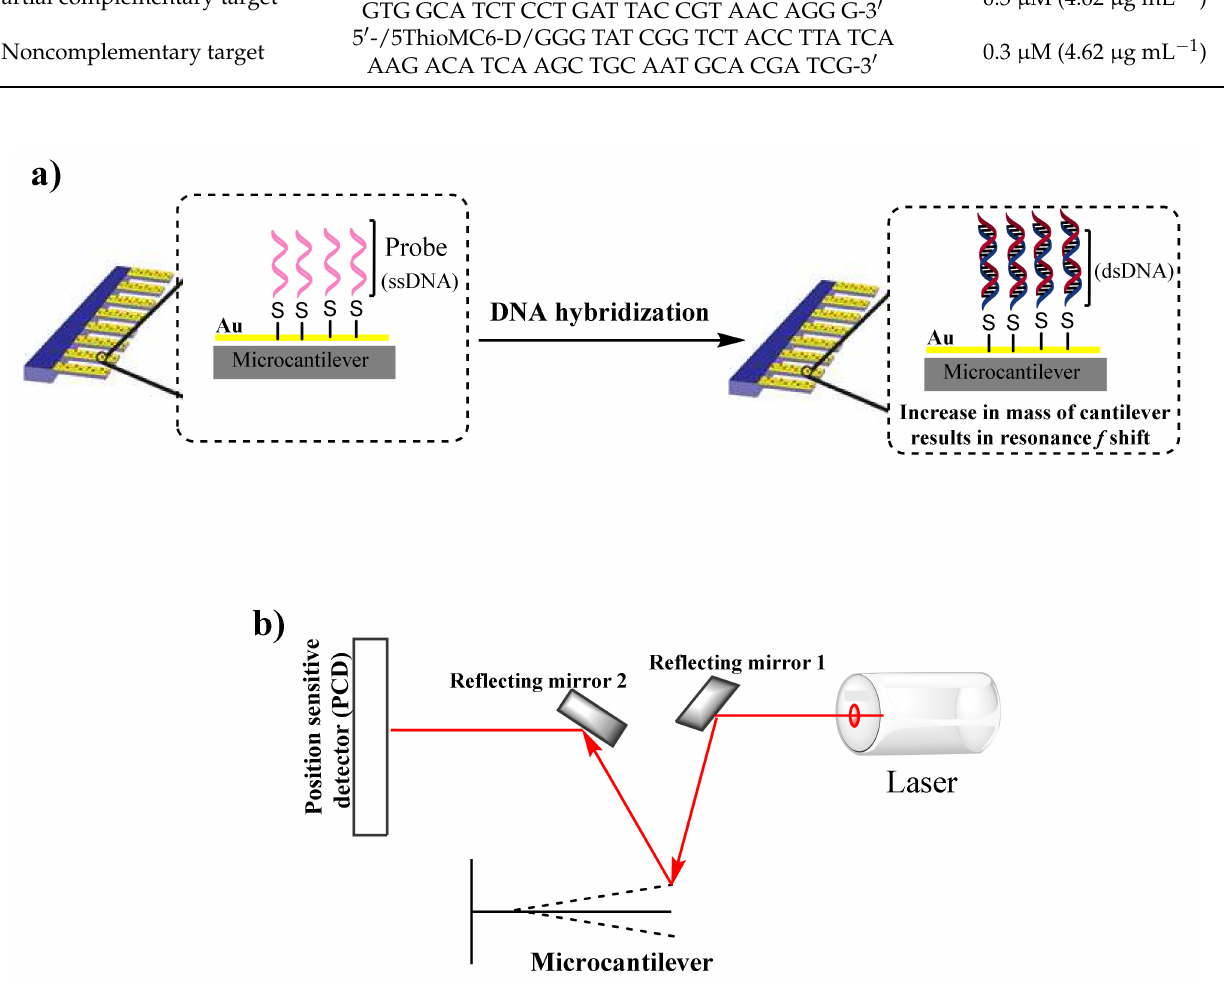
Figure 1. ( a ) DNA hybridization to immobilized microcantilever, which induces an increase in the microcantilever mass, resulting in a resonance frequency shift in the dynamic operation mode. ( b ) Schematic illustration of the measurement system (picomeasure